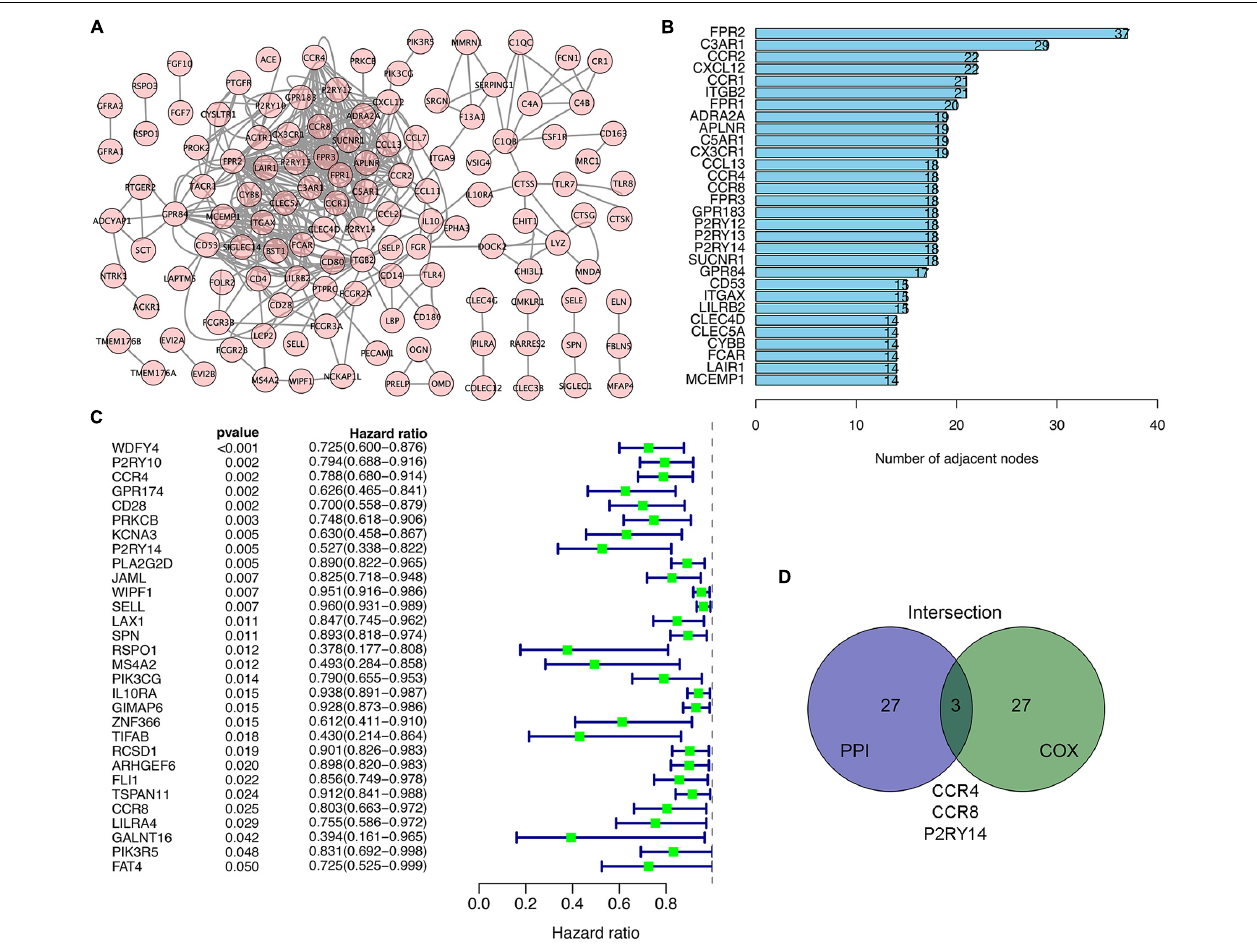
FIGURE 3 | Intersection analysis of top genes that derived protein-protein interaction (PPI) network and univariate COX processing. (A) PPI network constructed with the nodes with interaction confidence value > 0.90. (B) The top 30 genes ordered according to the number of adjacent nodes (from large to small). (C) Univariate COX regression analysis with DEGs. Listing the top 30 significant factors with p < 0.05 (from small to large). (D) The common factors shared by the top 30 genes in PPI and top 30 significant factors in univariate COX.